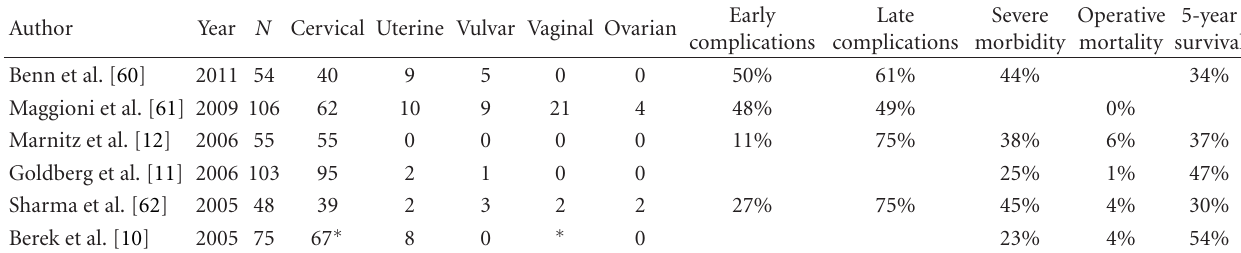
Table 1: Recent series of pelvic exenteration for gynecological